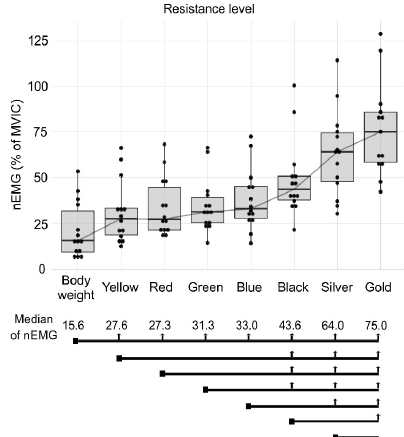
Figure 3. Median muscle activation (Median of nEMG) of the VM muscle for the different conditions: body weight, yellow, red, green, blue, black, silver and gold elastic band. The square point at the beginning of the black line marks the compared condition and the vertical arrows show significant differences between conditions. Results for VL nEMG are shown in Figure 4. Again, the body weight condition had the lowest values of nEMG (17.0%). For the yellow and red band conditions, a three-level increase in elastic resistance did not increase VL nEMG. For the green, blue and black band conditions, a one-level increment in elastic resistance did not increase VL nEMG. The gold band condition provided a greater VL nEMG (82.5%) than the other conditions.